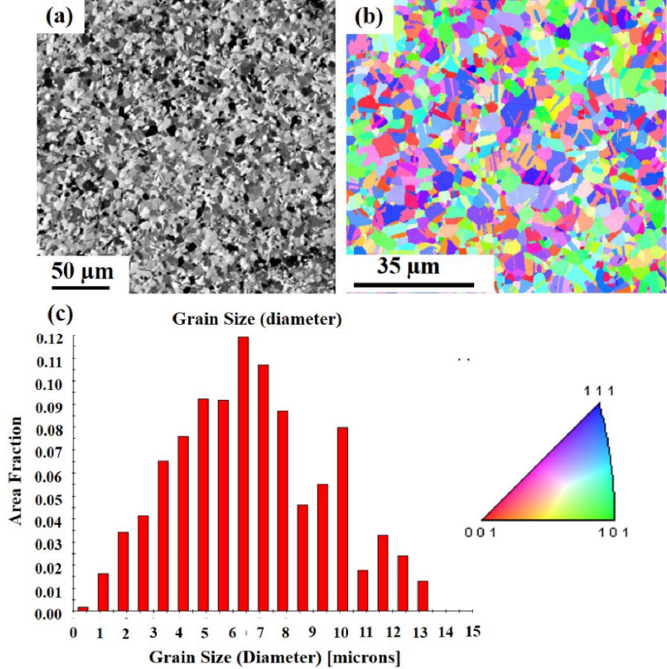
Figure 10. Normal grain growth of randomly oriented Cu films at 350 °C for an hour. ( a ) FIB top-view image. ( b ) EBSD orientation image. ( c ) Grain size distribution of the grains in pole Figure 9b. We compared the evolution of nt-Cu with (111)-oriented and randomly oriented Cu after annealing. ◦ During the heat treatment process of (111)-oriented nt-Cu at 250–350 C, the microstructure changes greatly, and the behavior of abnormal grain growth transforms into (200) large single crystal Cu